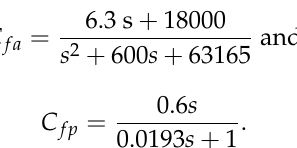
Figure 10. The open-loop characteristic position response of the controlled object.